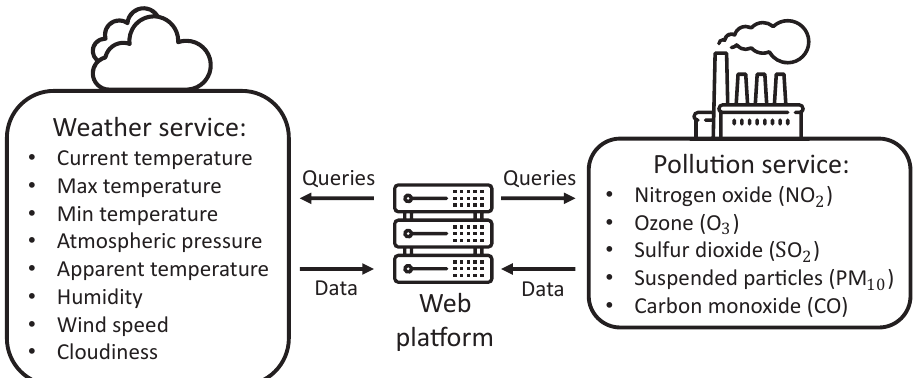
Figure 8. Data obtained from each external